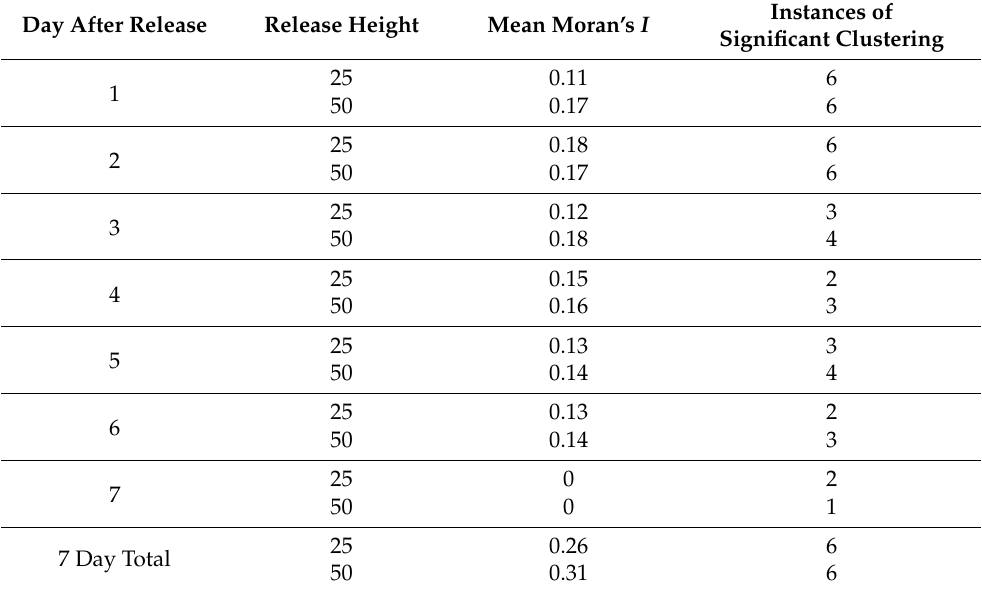
Table 1. Summary of Moran’s I values for each release height and day after release ( n = 6). I values shown are the mean from all replicates, and instances of significant clustering indicate the number of replicates out of 6 where a Monte Carlo procedure identified clustering to be more significant than random ( p < 0.05). Mean Moran’s